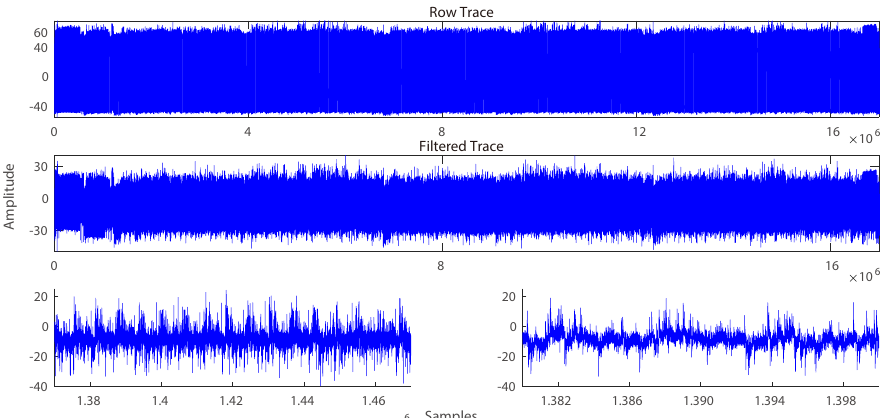
Figure 2. Full trace of NTRU Open Source: The top figure is a raw trace, the middle figure is a filtered trace, and the bottom two are enlarged figure of the filtered